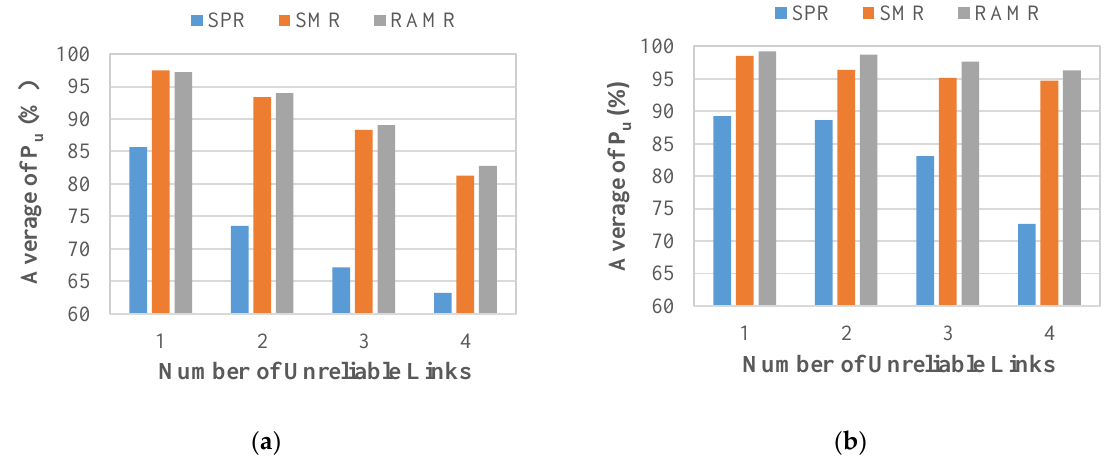
Figure 11. Reliabilities when the number of unreliable links n varies from 1 to 4 in ( a ) Topology 1; ( b ) Topology 2.